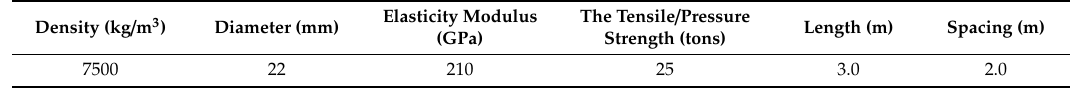
Table 3. The parameters of anchor.